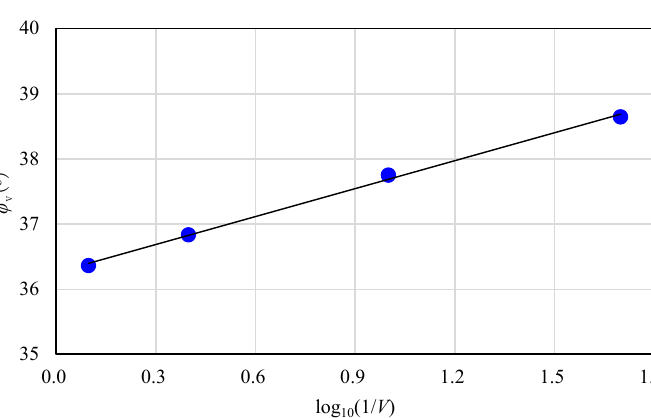
Figure 6. Relationship between average value of the rate-dependent friction angle ϕ v and log 10 (1 / V ) of cement discontinuity samples.